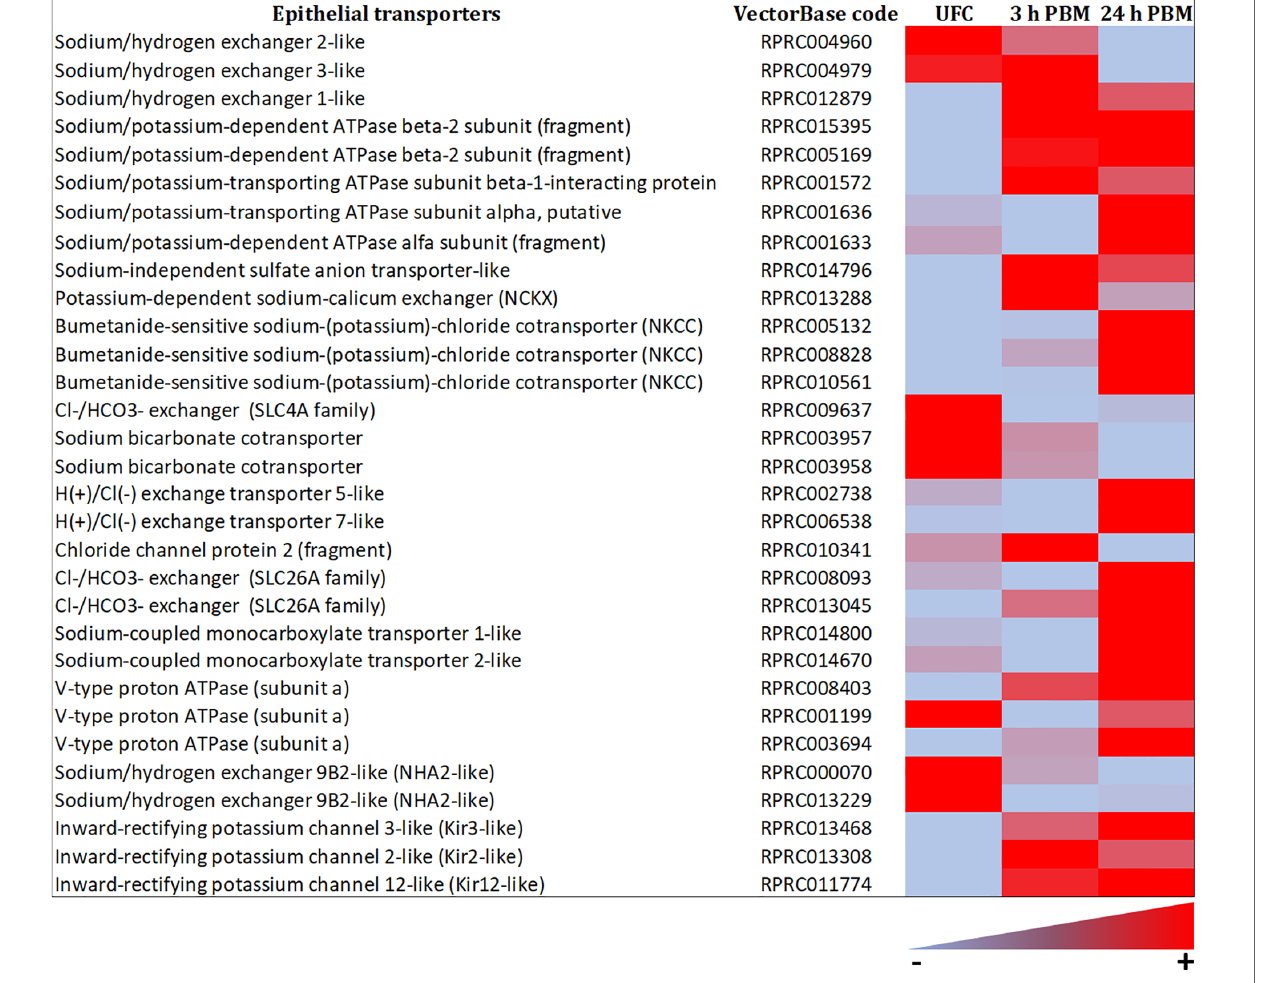
FIGURE 10 | Heat map comparing the mRNA expression levels of epithelial transporters in Malpighian tubules from insects unfed (UFC), 3 h and 24 h post blood meal (PBM). The input data is the readcount value from gene expression level analysis after normalization and is presented by means of a color scale, in which light blue/red represent lowest/highest expression. DESeq was used to perform the analysis. Details of transcript expression are shown in Supplementary Worksheets 1 , 2 .